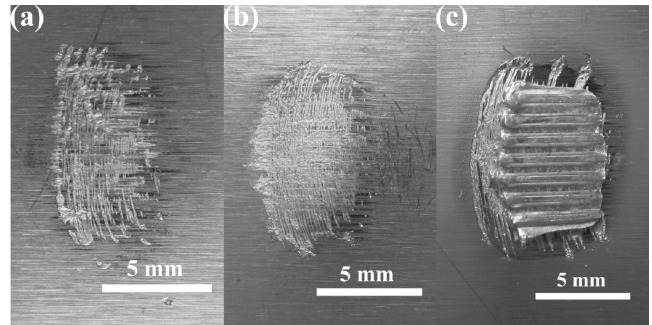
Figure 7. The fractures surfaces of Cu-Cu joints after lap shear testing revealing a change in fracture mode from interfacial cleavage to nugget pull-out: ( a ) 400 J; ( b ) 800 J and ( c ) 2000 J.